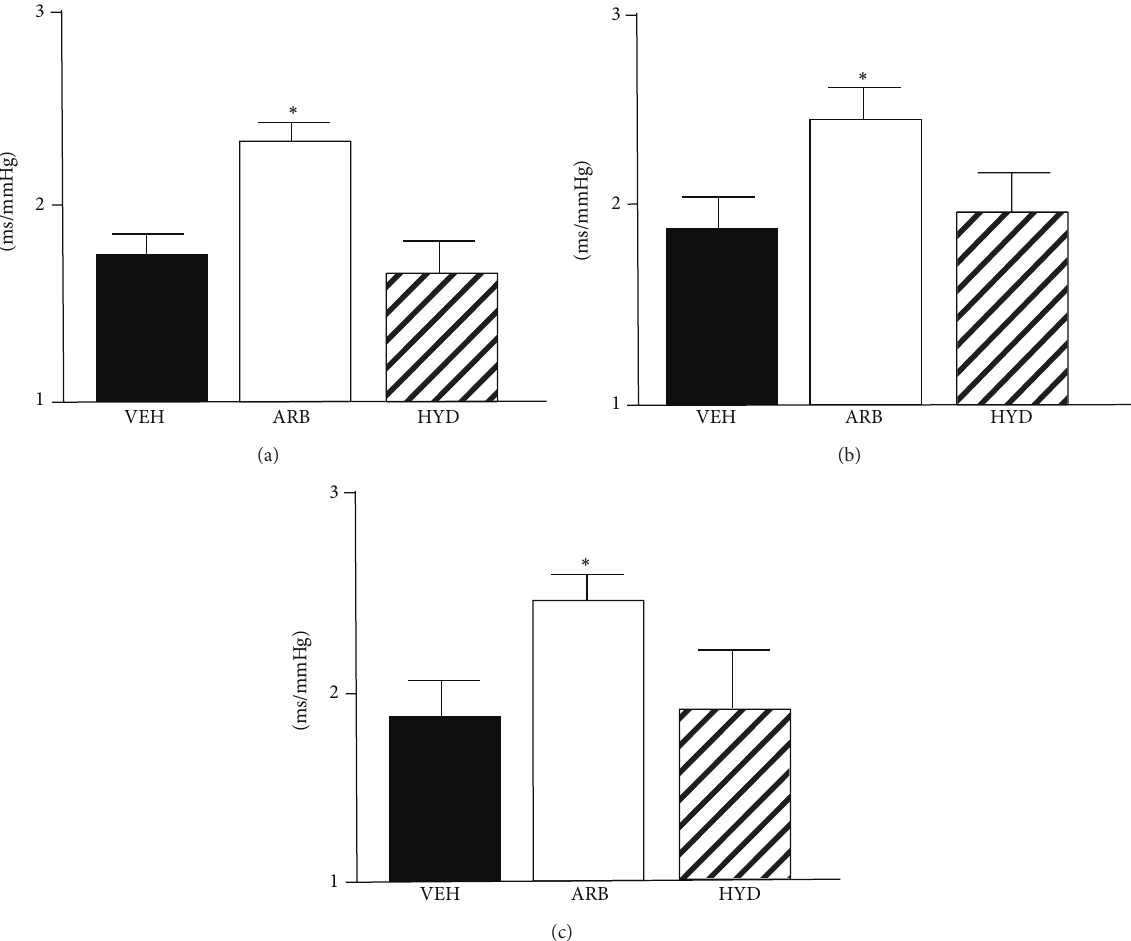
Figure 4: Baroreflex sensitivity calculated by spontaneous sequence method in stroke-prone spontaneously hypertensive rats treated with intracerebroventricular infusion of losartan (ARB, 𝑛 = 5 ), oral-administered hydralazine (HYD, 𝑛 = 5 ), and intracerebroventricular infusion of vehicle (VEH, 𝑛 = 5 ) at early morning (a), after morning (b), and night (c). ∗ 𝑃 < 0.05 versus